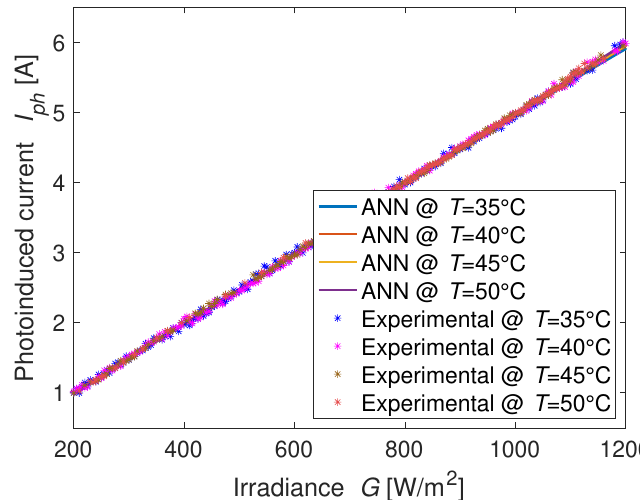
Figure 6. ANN identification of the photoinduced current in healthy condition.